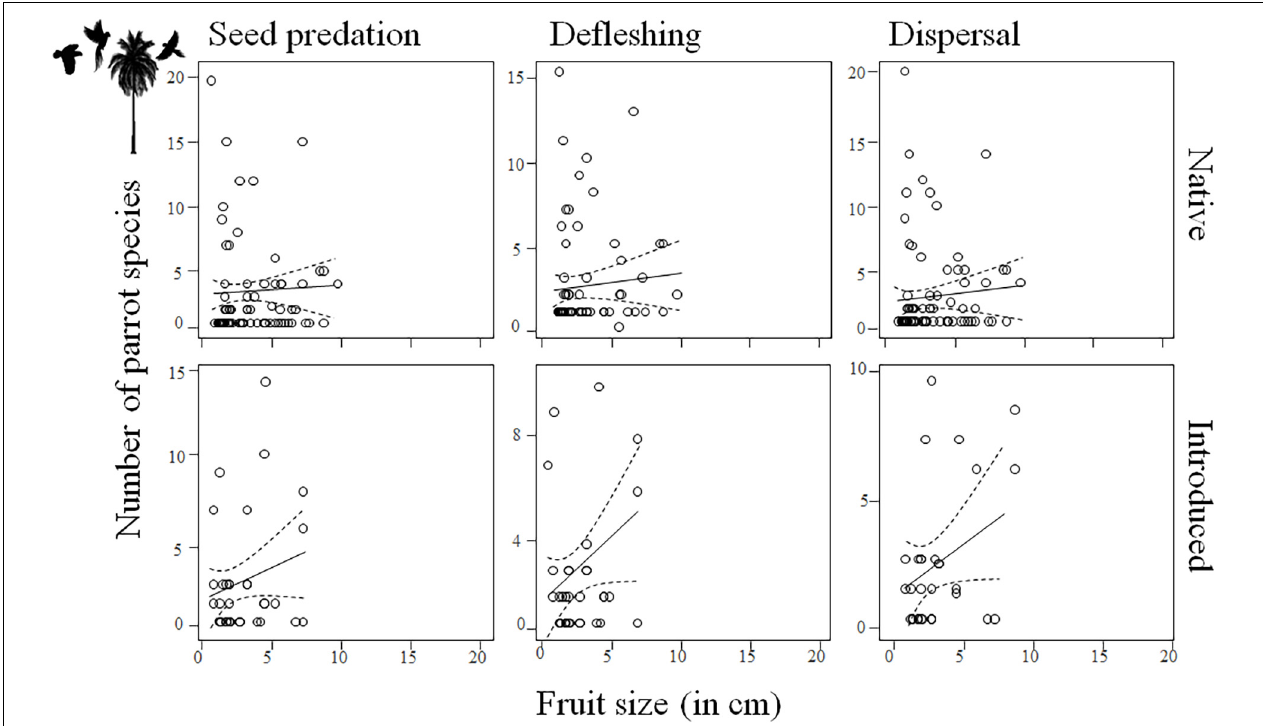
FIGURE 4 | Number of parrot species interacting with palms (i.e., seed predation, defleshing, and dispersal) differing in fruit size (measured as fruit length, in cm) across six main realms of the world and in areas where palms were native and introduced.